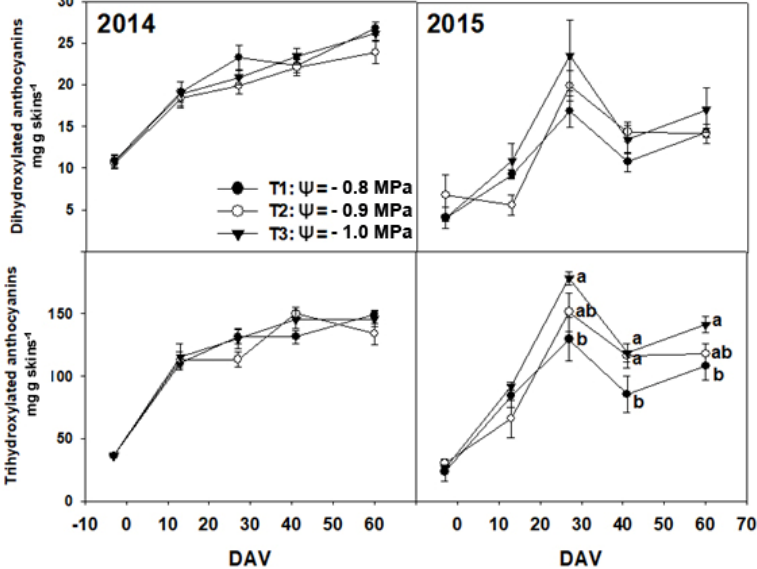
Figure 3. Dihydroxylated and trihydroxylated anthocyanin concentrations in Cabernet Sauvignon grape skins throughout ripening in the 2014 and 2015 seasons. Vertical bars indicate standard error from five replicates. Different letters indicate significant differences between treatments (Tukey’s HSD test, p < 0.05). The proportion of the different types of anthocyanins at harvest did not show signif- icant differences between treatments (Figure 4).